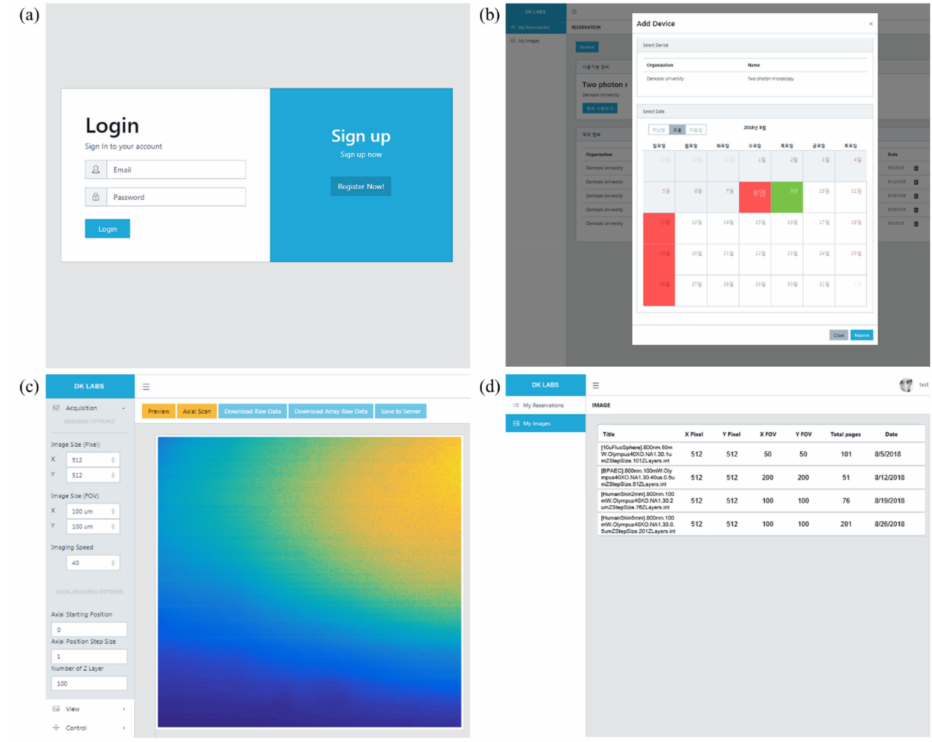
Figure 6. Page screenshots of the web service user interface: ( a ) login and sign up page; ( b ) equipment selection page; ( c ) equipment operation page; and ( d ) data log page.